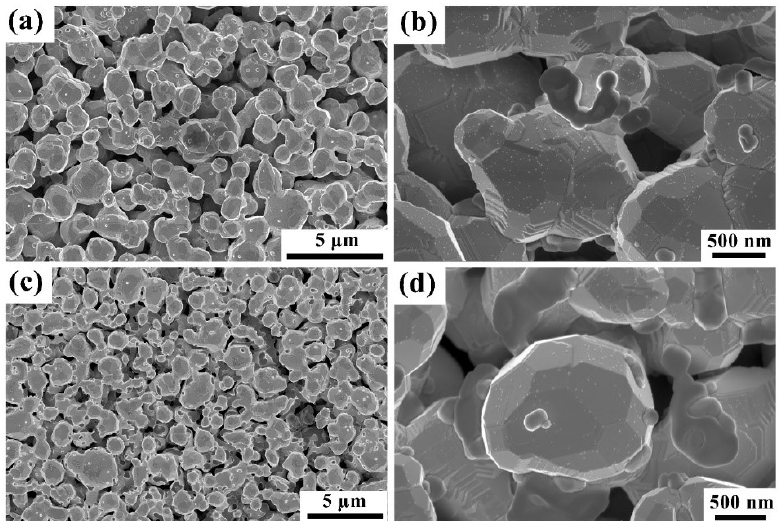
Figure 1. Surface morphology of two scandate cathodes. ( a , b ) are low- and high-magnification SEM images of the surface of cathode #1. ( c , d ) are low- and high- magnification SEM micrographs of cathode #2. All micrographs were obtained in secondary electron imaging mode.